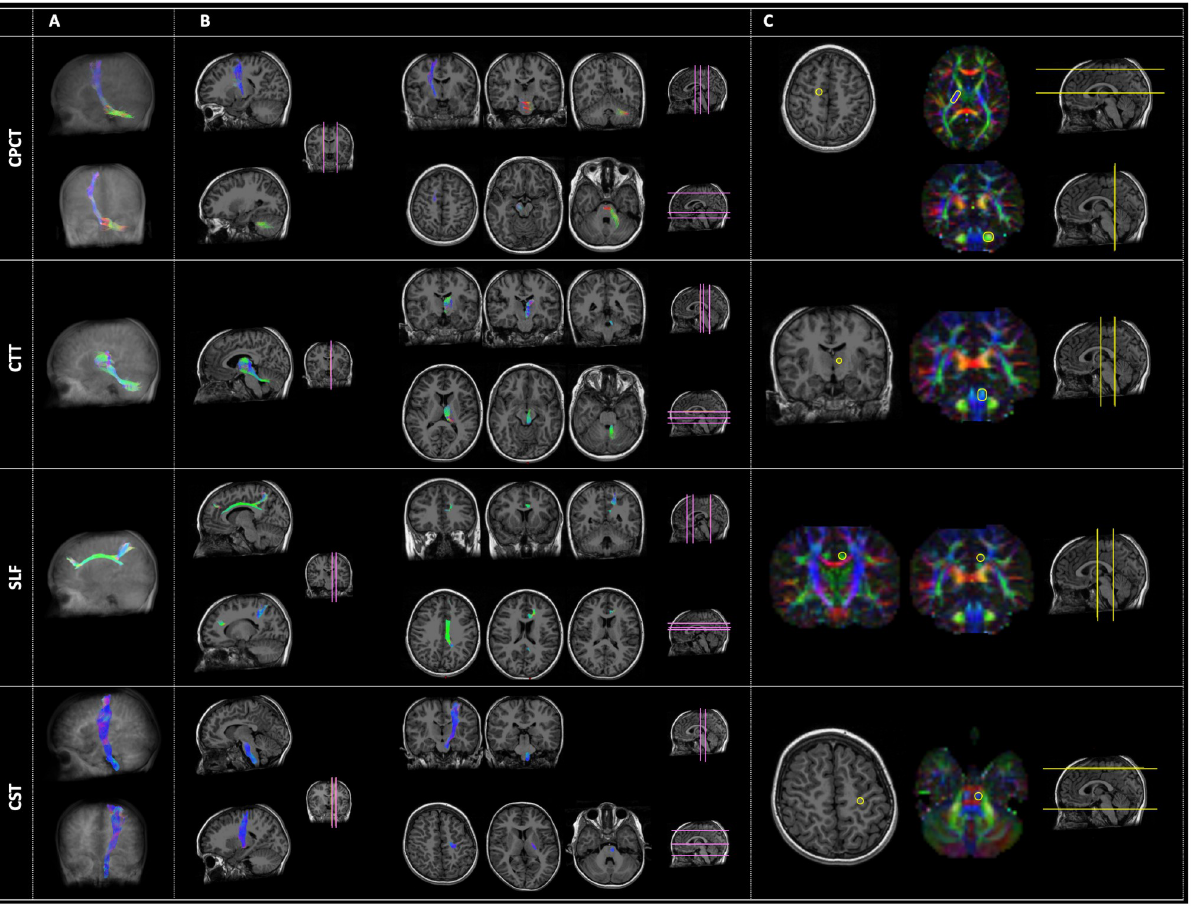
Fig 1. Examples of the four tracts of interest: From the top, the Cortico-Ponto-Cerebellar Tract (CPCT), the Cerebellar-Thalamic Tract (CTT), the Superior Longitudinal Fasciculus (SLF) and the Cortico-Spinal Tract (CST). Panel A represents the three-dimensional reconstruction of each tract in a glass brain. In panel B, the pathway of tractography is depicted in some representative slices with different orientation: Sagittal (right side of the panel), coronal (left side of the panel, upper rows), and axial (left side of the panel, lower rows). The location of these slices is reported in pink color on a reference brain. Panel C reports the ROIs (yellow circles) used for the tractography of each tract, both in anatomical images or in the diffusion- encoded-color (DEC) maps. Analogously to panel B, the location of these images is represented in yellow color on a reference brain. The order of representation of images corresponds to the Right-Left (R-L) direction for sagittal images, to the Anterior-Posterior (A-P) direction for coronal images, and to the Superior-Inferior (S-I) direction for axial ones. The color code of tractography pathways and DEC maps is the standard red-green-blue (RGB) code for diffusion: red for R-L direction, blue for S-I, and green for A-P.